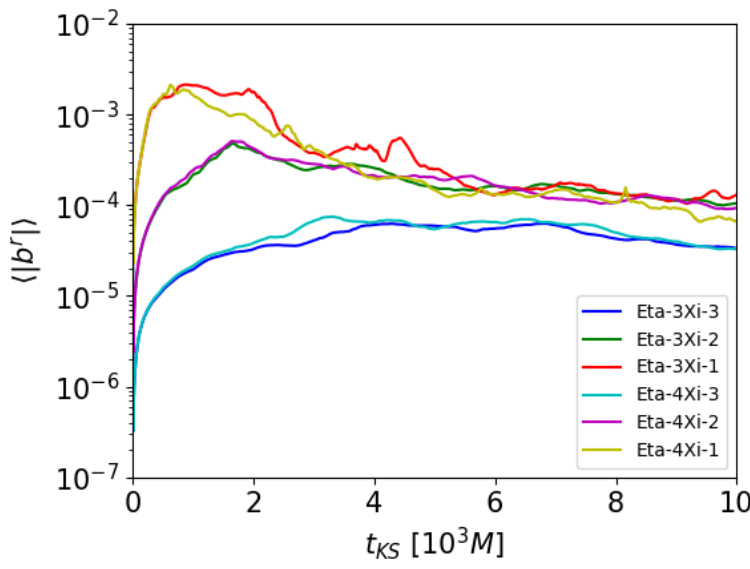
Figure 1. Time evolution of | b r | averaged on the disk for each